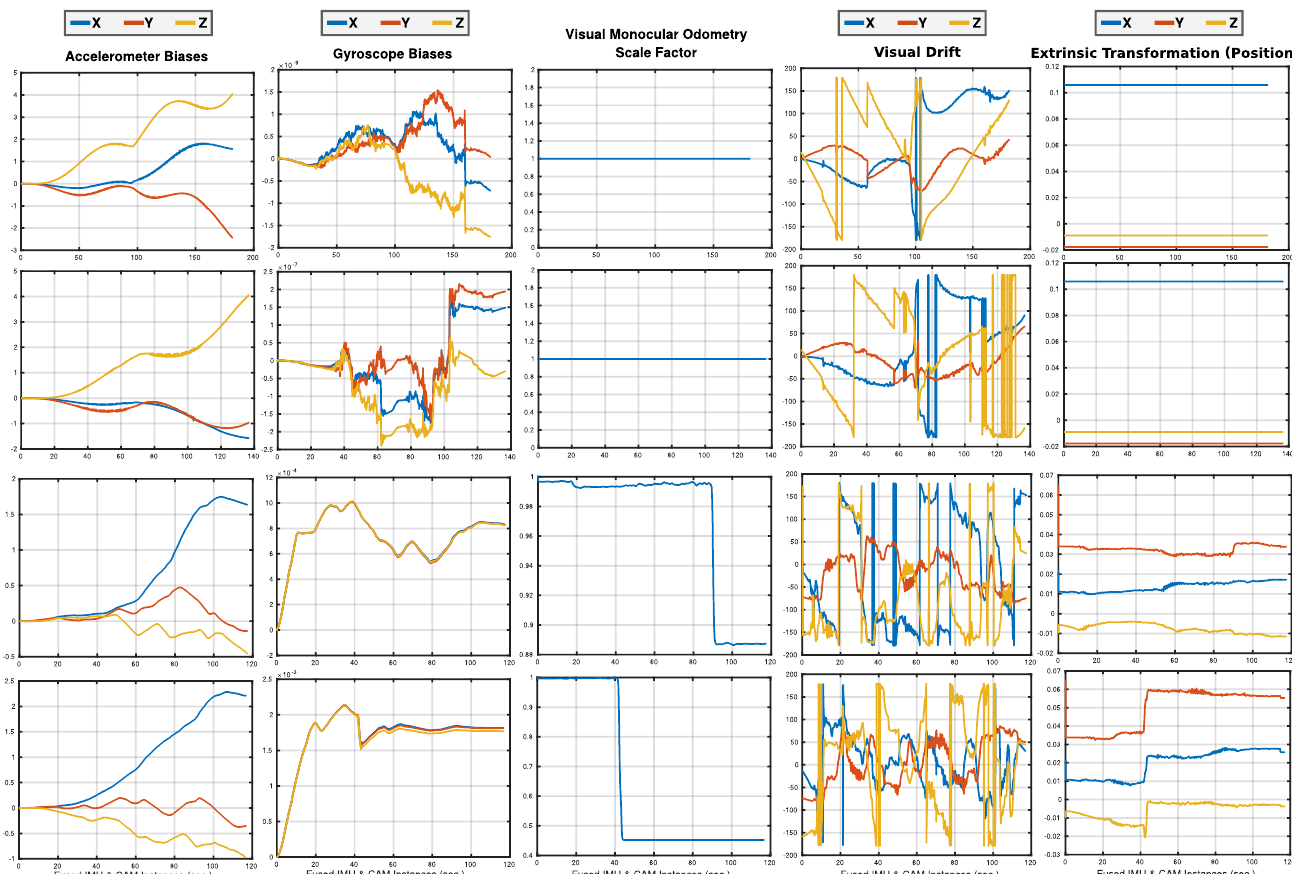
Figure A1. Our ES − EKF estimated states. Columns from left to right: IMU (accelerometer/gyroscope) biases b a , b ω , odometry scale factor λ , visual drift orientations q w v , and IMU-camera translation online calibration p c . Rows 1,2 for sample Fast Flight sequences (gps5, gps10) and rows 3, 4 for sample i EuRoC sequences (V2-02, V2-03),